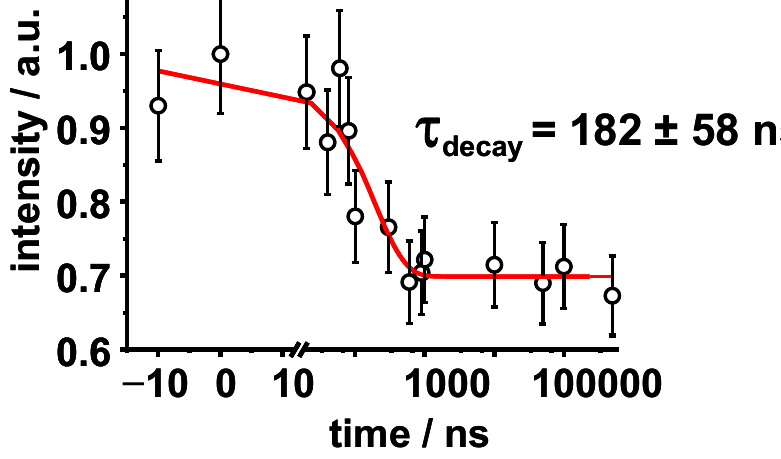
Figure 6. Time-resolved integrated intensity of the Bragg spot. The decay follows a mono- exponential decay with a time constant of 196 ns. The decrease of intensity was analyzed by the Patterson